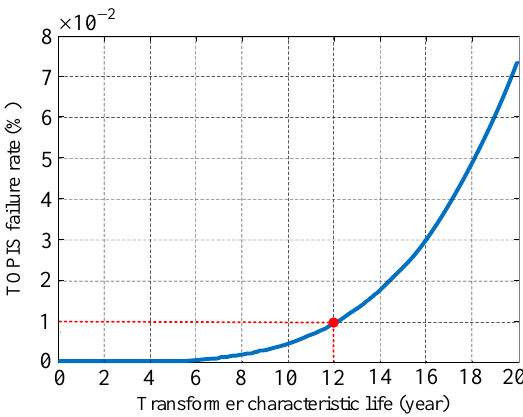
Figure 9. Failure rate curve of the TOPIS.